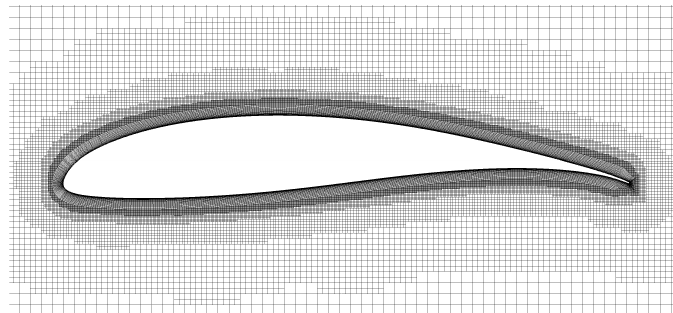
Figure 7. 2D section of the trimmed hexahedral mesh